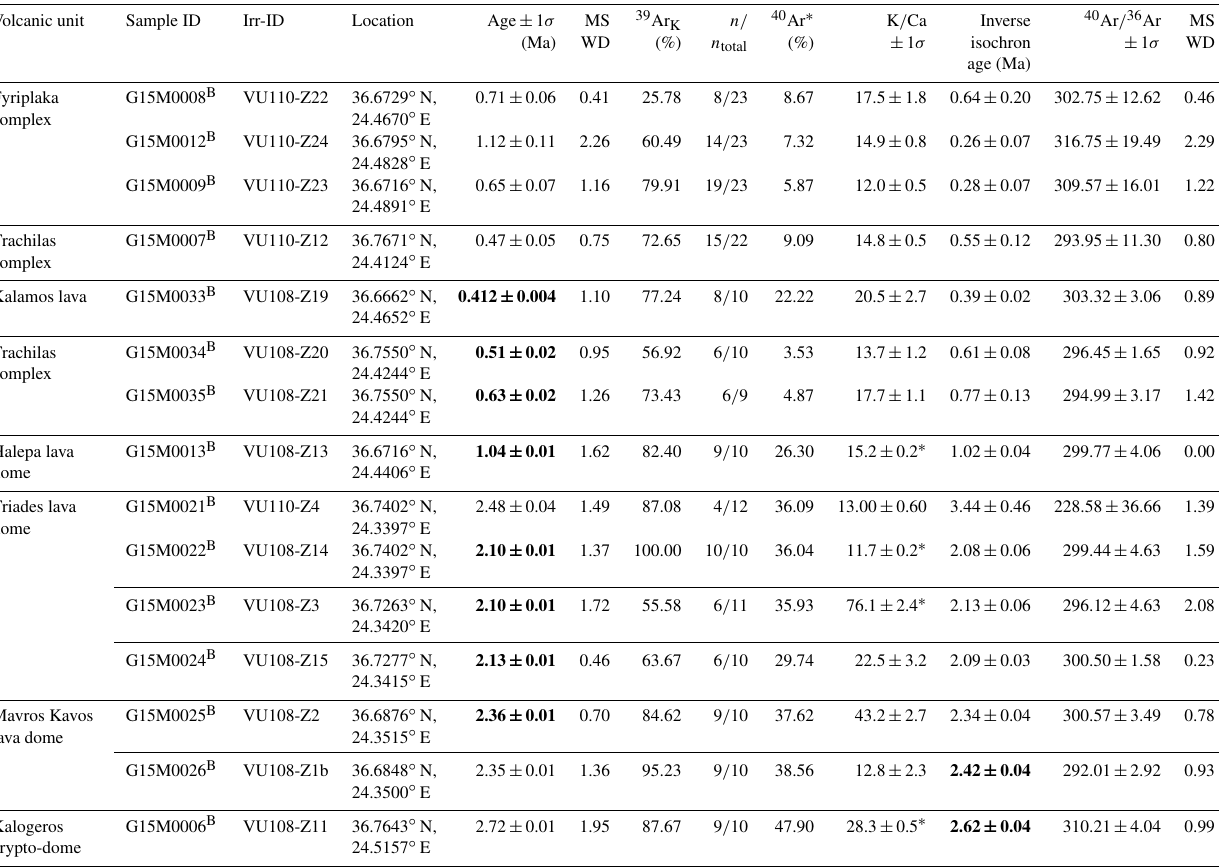
Table 3. 40 Ar / 39 Ar results of single-grain fusion analyses on the Milos volcanic field. Volcanic